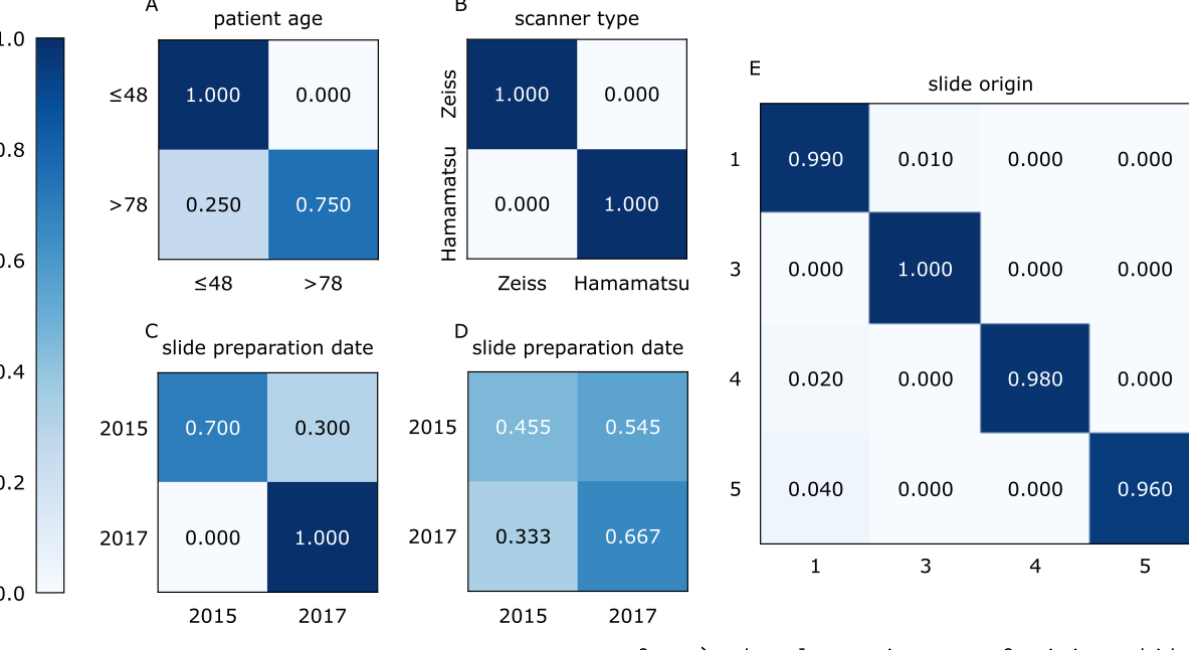
Figure 2. Distributions of the models’ predictions for tasks 1 to 4 on slide level for ResNet50 (run 1). (A) Task 1 (patient age) prediction. (B) Task 4 (scanner type) prediction. (C, D) Comparison of the two most distinct classification subtasks for task 2 (slide preparation date), where balanced accuracy was either at a maximum (C: data set 2, 2015 versus 2017) or at a minimum (D: data set 1, 2015 versus 2017). (E) Task 3 (slide origin) prediction, with the data set number displayed rather than the data set origin for better